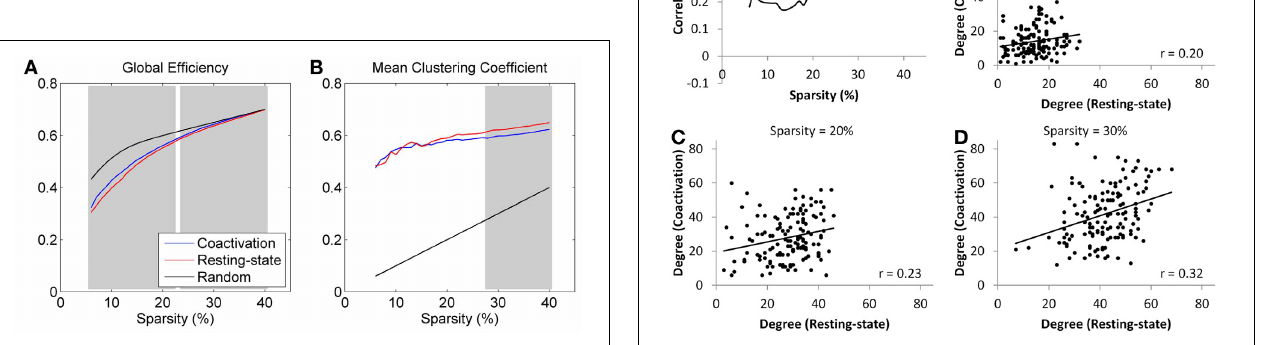
1000 permutations.